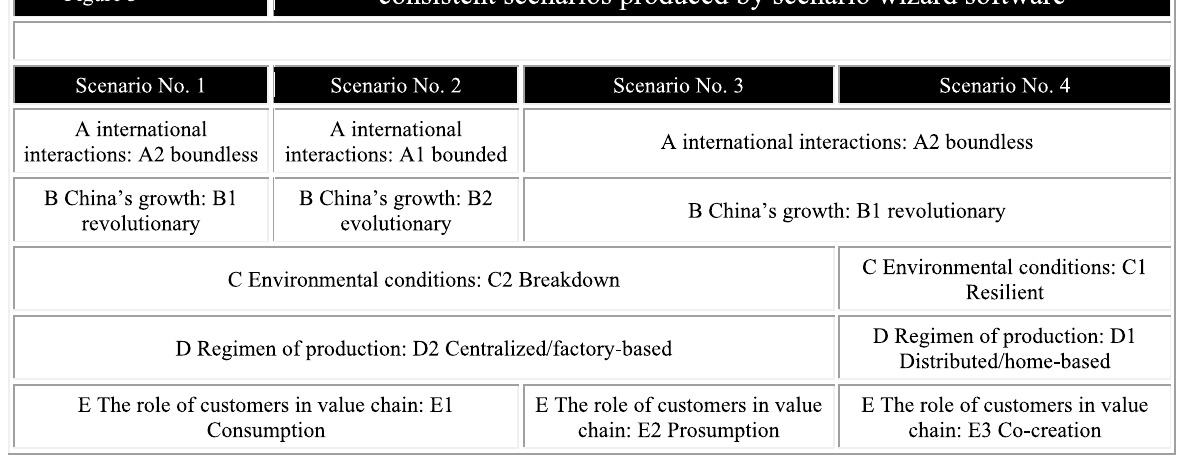
Fig. 3 Consistent scenarios produced by scenario wizard